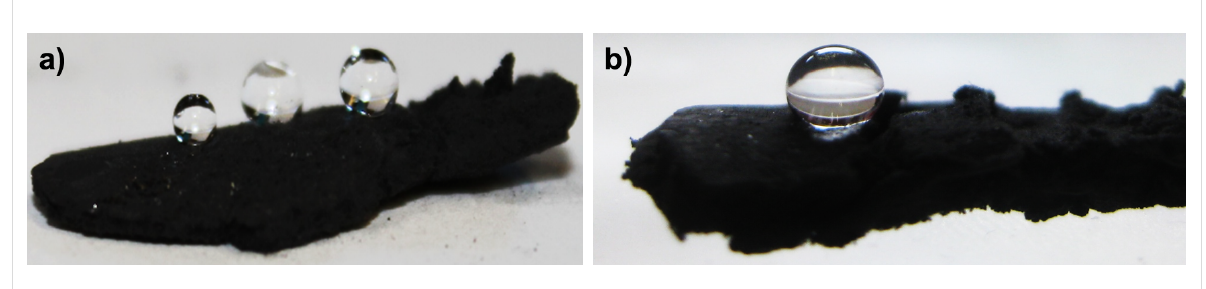
Figure 4: Photographs of water droplets of different volumes (a) and contact angle profile of a single drop (b) on the bulk material.